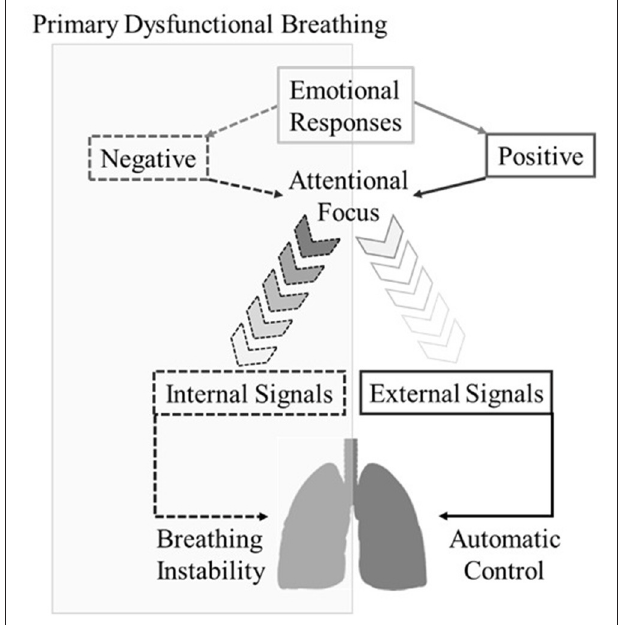
FIGURE 1 | Diagrammatic representation of the psychosomatic theory of primary dysfunctional